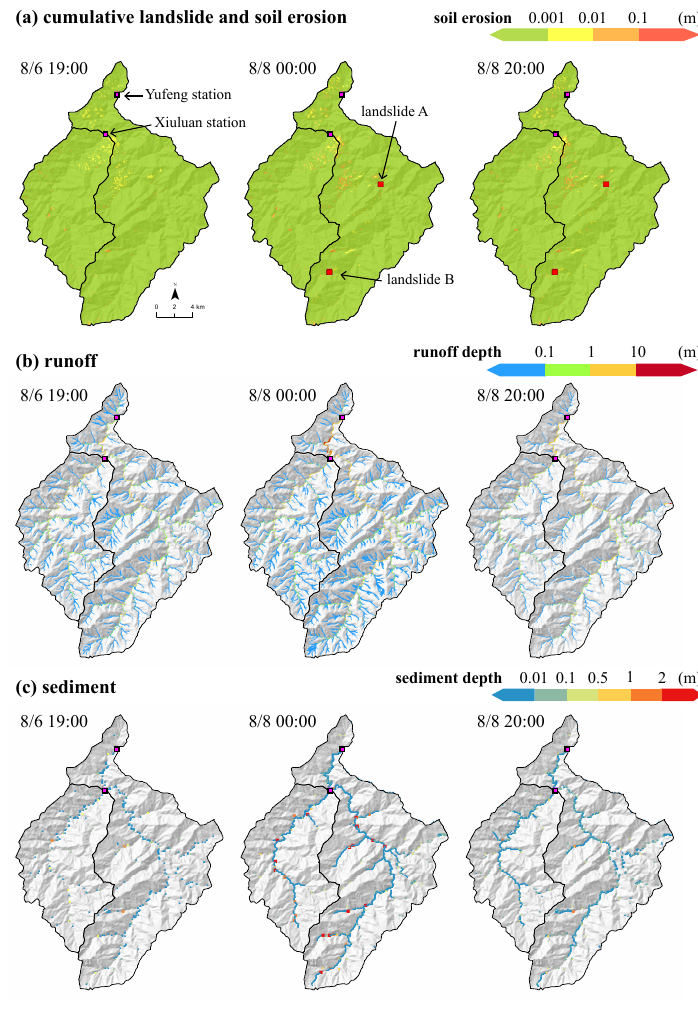
Figure 6. Spatial distribution of mass produced by landslide and soil erosion, runoff, and sediment discharges in Xiuluan and Yufeng watersheds at three instants. ( a ) Cumulative landslide and soil erosion; ( b ) runoff; ( c )